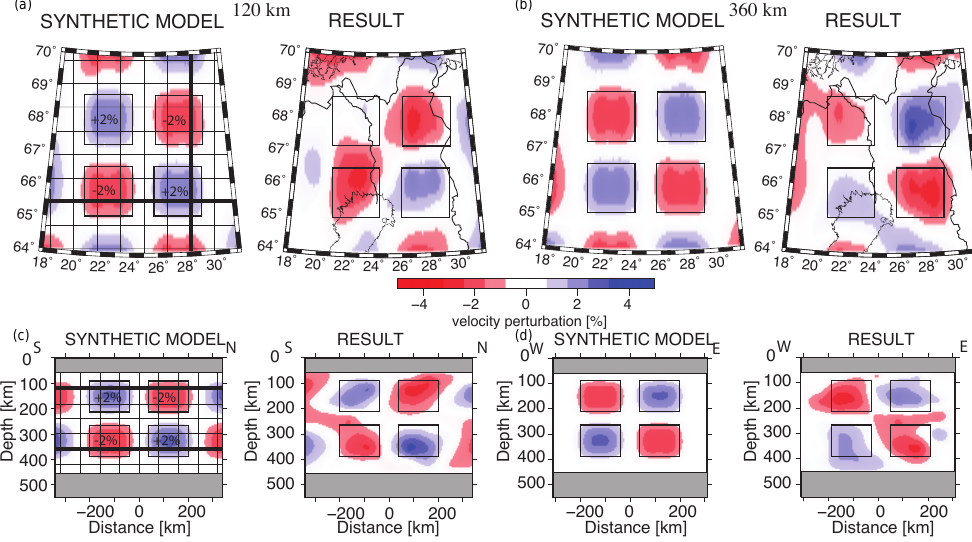
Figure 9. Chequerboard test results. Two horizontal sections are shown at the depths of 120 (a) and 360km (b) as well as two vertical sections, one in SN direction (c) and one in EW direction (d) . For each section, both the model used to compute the synthetic data set and the result after inversion are shown. The model plot of subplot (a) shows the grid used and the locations of the vertical and horizontal sections with thicker lines, respectively. The locations of the anomalies are bordered with rectangles. The areas that were not inverted are marked with grey